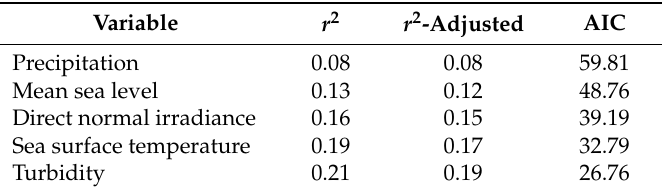
Table 2. Akaike Information Criterion (AIC) model with those environmental variables that explained enterococci concentration variability in surface waters at Escambron